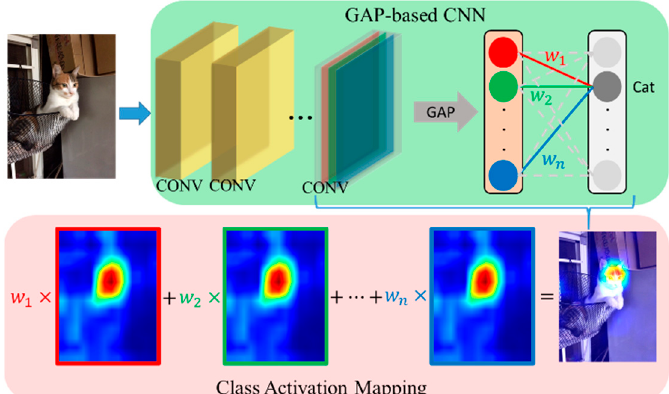
Figure 2. CAM architecture.